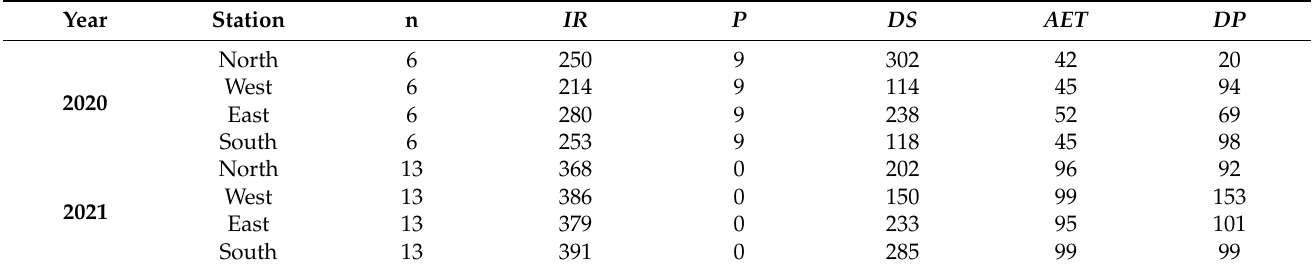
Table 1. Water budget component results for each soil monitoring station (North, West, East, and South) during the 2020 and 2021 irrigation seasons. The water budget components are irrigation ( IRR ), precipitation ( P ), total change in soil water ( ∆ S ), evapotranspiration ( AET ), and deep percolation ( DP ). The season-cumulative results for all irrigation applications (n) for each station are shown. All results are reported in